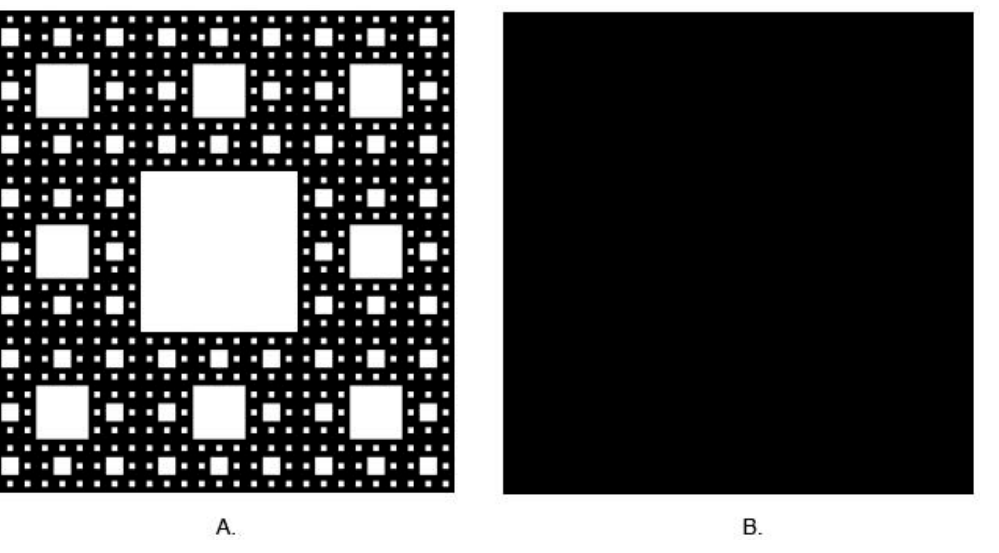
Figure 1. ( A ) Sierpinski’s carpet (FD ≈ 1.8928.), ( B ) square (FD = 2) (generated by h tt ps://cod-